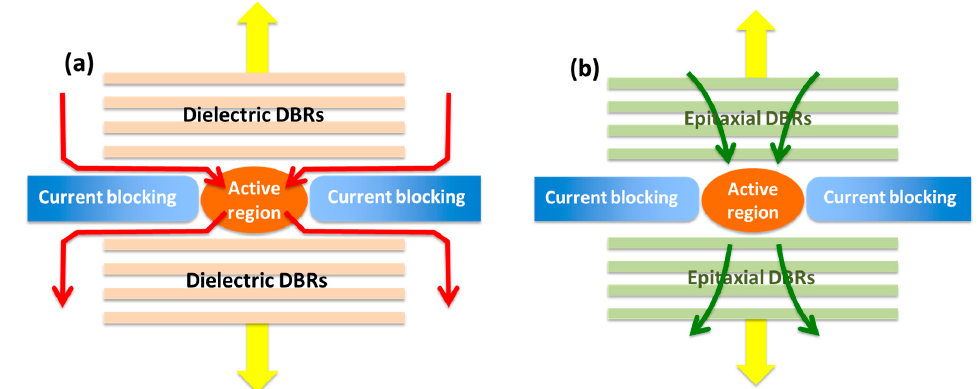
Figure 3. Schematic illustrations of vertical cavity surface-emitting lasers (VCSELs) employing non-epitaxial ( a ) and epitaxial ( b ) DBRs. The pathways for current injection are shown in red and green arrows for the non-epitaxial and epitaxial mirrors, respectively.